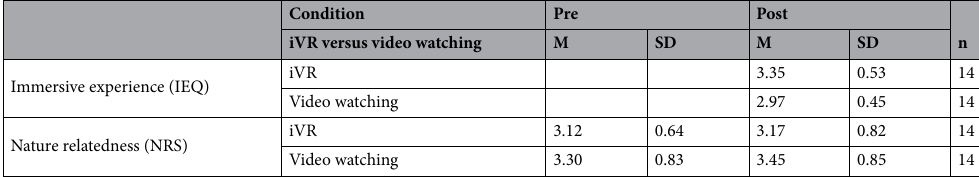
Table 1. Descriptive statistics for immersive experience and nature relatedness, pre- and post-experiment. 1 = 5-point Likert scale (1 = strongly disagree to 5 = I strongly agree).